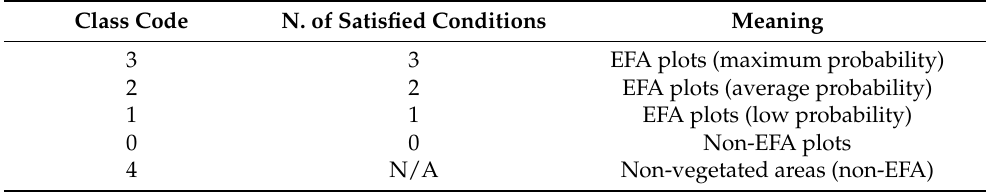
Table 2. Class code meaning according to the number of satisfied conditions set by Equation